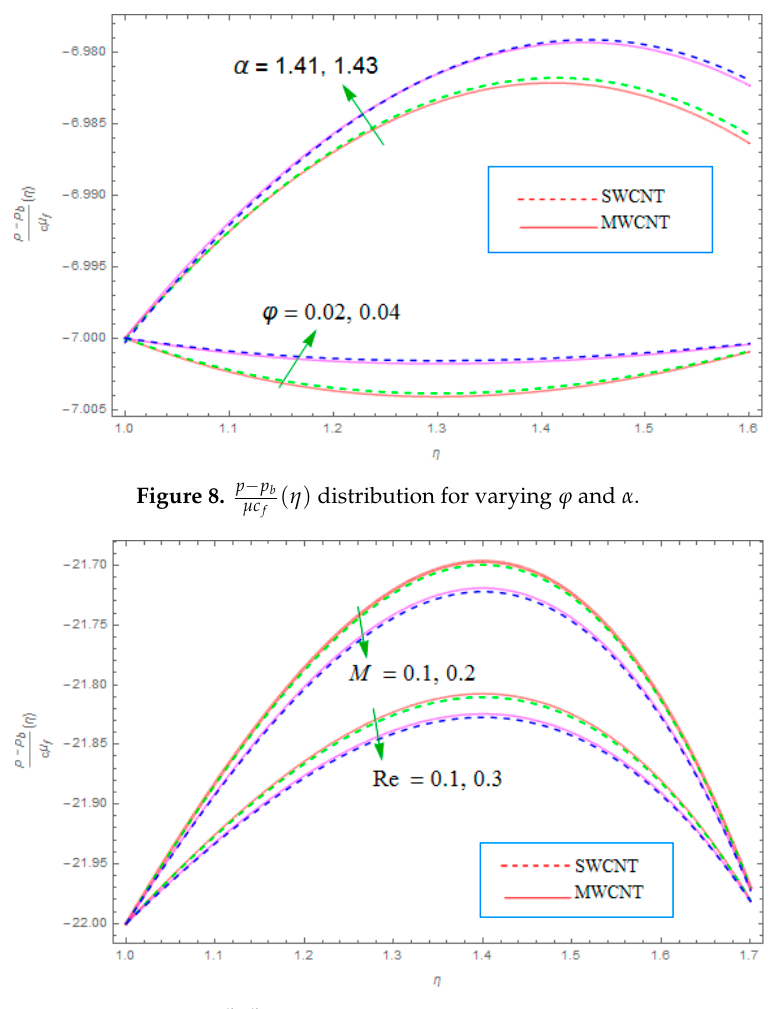
( η ) distribution for varying M and Re. Figure 9. p − p b ( ) b µ c f Figure 9. distribution for varying M and Re .